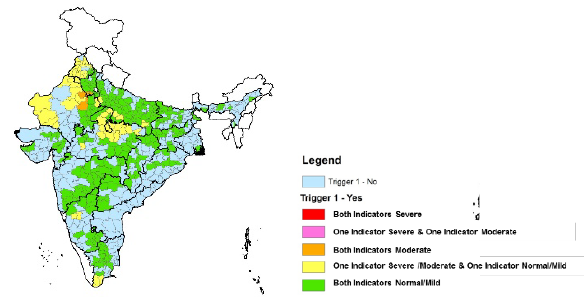
Fig 25. Drought Assessment map 2017